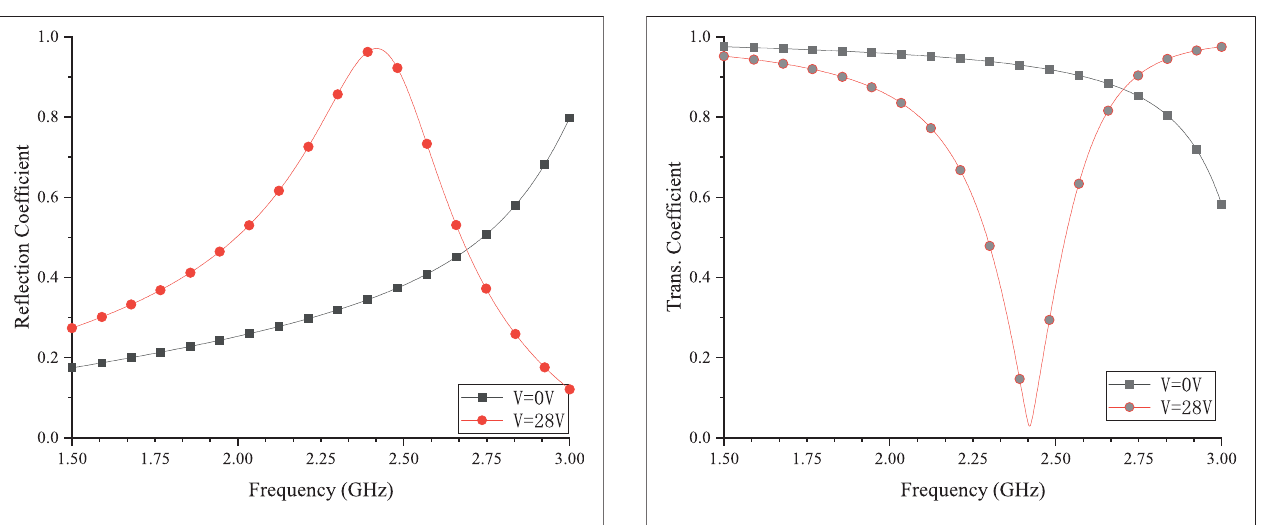
FIGURE 4 | The re fl ection coef fi cient of a recon fi gurable metasurface at different voltages.